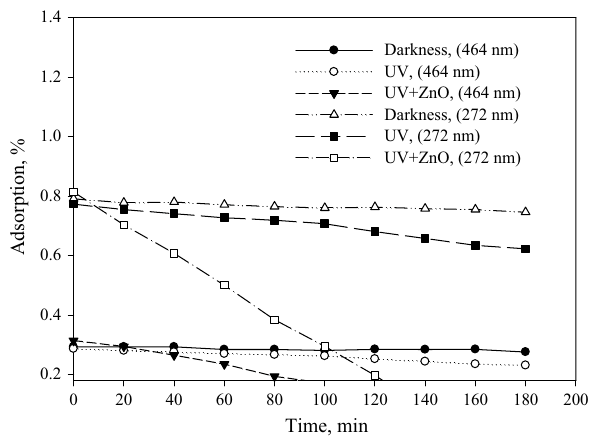
Fig. 6 Changes in absorption with time at wavelengths of 272 and 464 nm, conditions 200 mg L −1 of photocatalyst, methyl orange 10 mg L −1 and pH 6